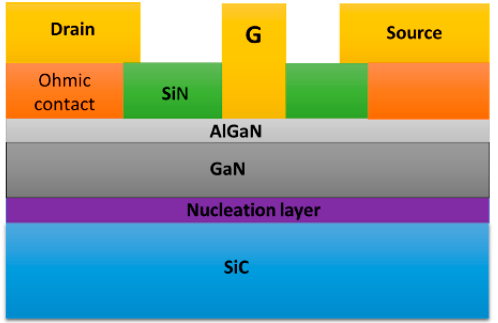
Figure 8. HEMT structure with SiC substrates. The nucleation layer, also known as the thermal boundary resistance (TBR), is used to achieve mesh tuning for the SiC and GaN layers and decrease mechanical stress and flaws in the GaN layer. The upper half of the GaN layer includes the 2DEG, and the AlGaN layer forms a heterojunction with the GaN layer. Reprinted with permission from ref. [123]. Copyright 2021 MDPI.